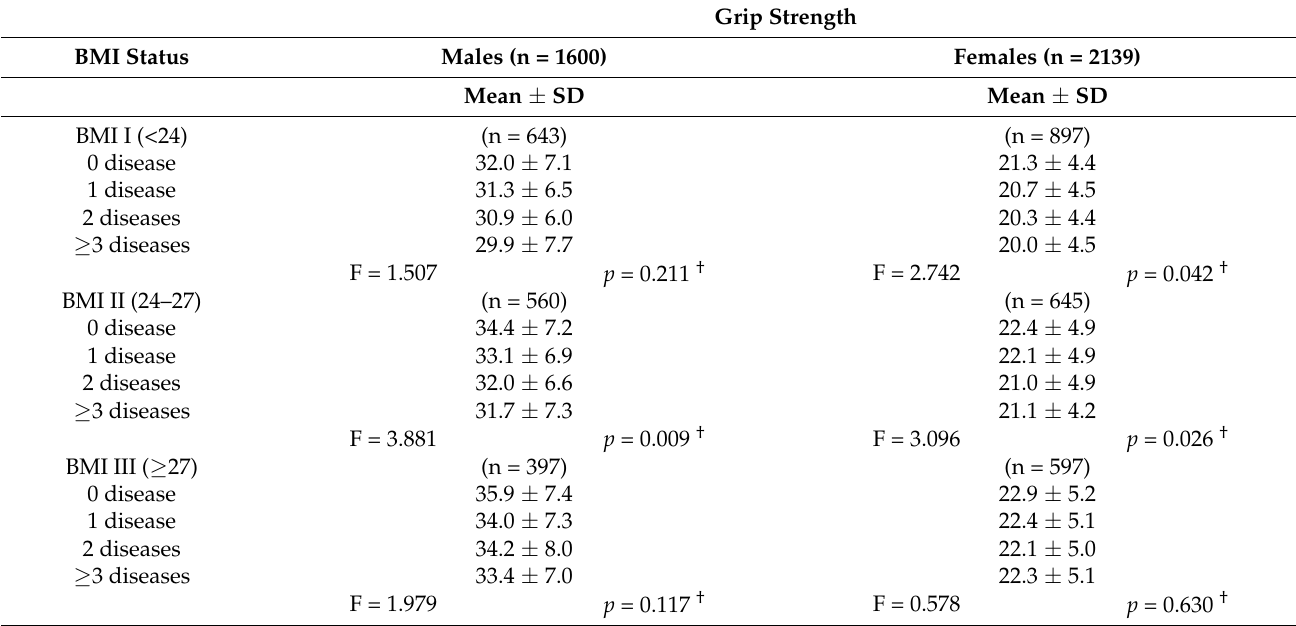
Table 5. Distributions (mean ± SD) of grip strength among different chronic diseases statuses and BMI status with sex specification (n =